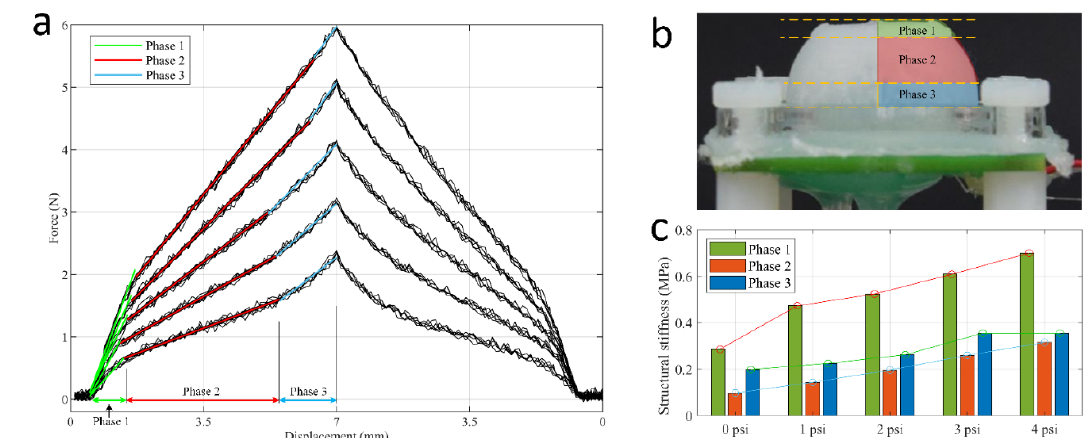
Figure 7. ( a ) The force-displacement data was divided into three different stages based on their gradient. The straight lines stand for linear-fit results of the trend of stiffness change. ( b ) Approximate phase division on a prototype of the inflatable dome. ( c ) Bar chart of structural stiffness factor, K , for Ecoflex 0050 sample by 6 mm indenter. The bars stand for linear-fit stiffness of each phase of the sensor. The stiffness of second phase of sensor increased linearly with increase in pressure.